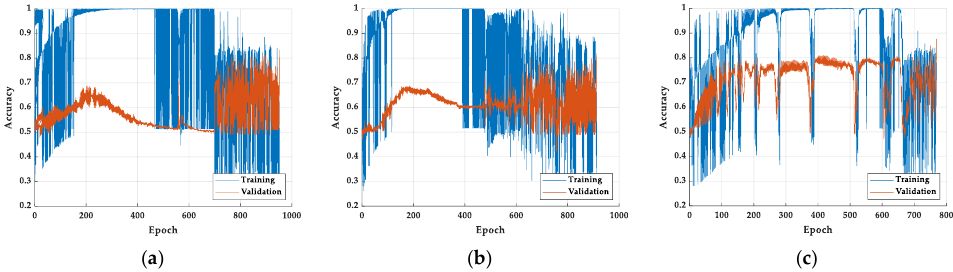
Figure 6. The accuracy vs. epochs of the training process: ( a ) face model, ( b ) eye model, and ( c ) fusion model.